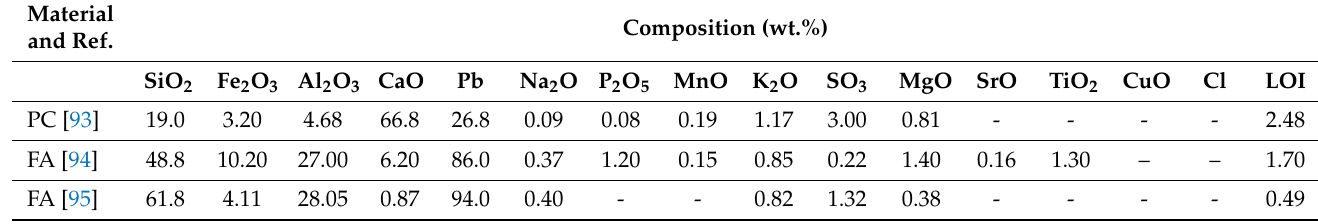
Table 2. Oxide composition for PC and FA binder